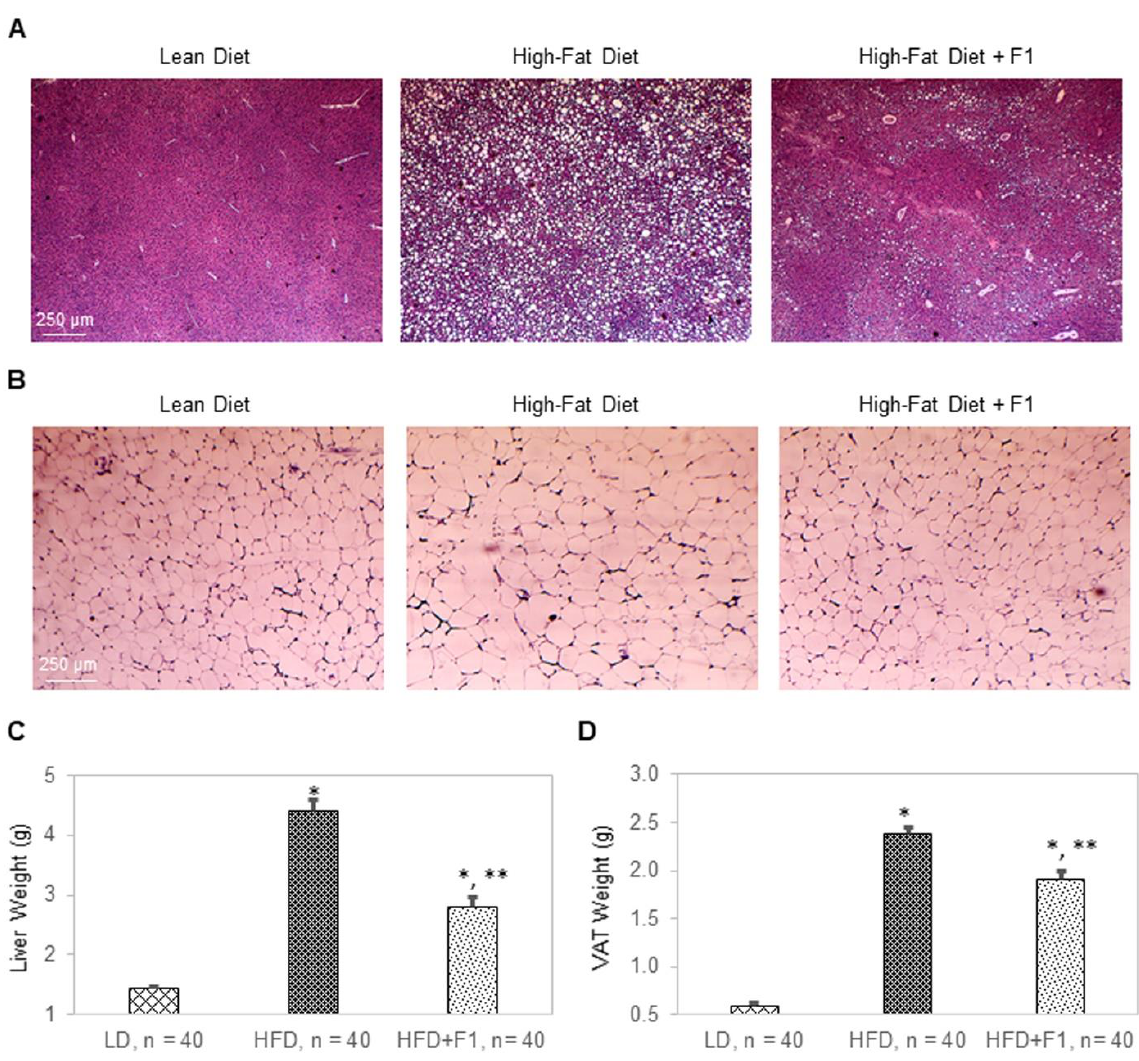
Figure 12. F1 composition reduces liver steatosis and visceral adiposity. H&E histology of ( A ) liver tissues and ( B ) visceral adipose tissues collected from LD, HFD, and HFD + F1 mice. Images were acquired with brightfield microscopy. Lipid droplets are indicated as white dots. Average weight of ( C ) liver tissues and ( D ) visceral adipose tissues (VAT) as functions of animal groups on specified diets. Error bars are the standard deviations of forty mice per animal group. Single and double asterisks indicate a statistical significance of a p - value ≤0.01 versus LD and HFD animal groups, respectively.